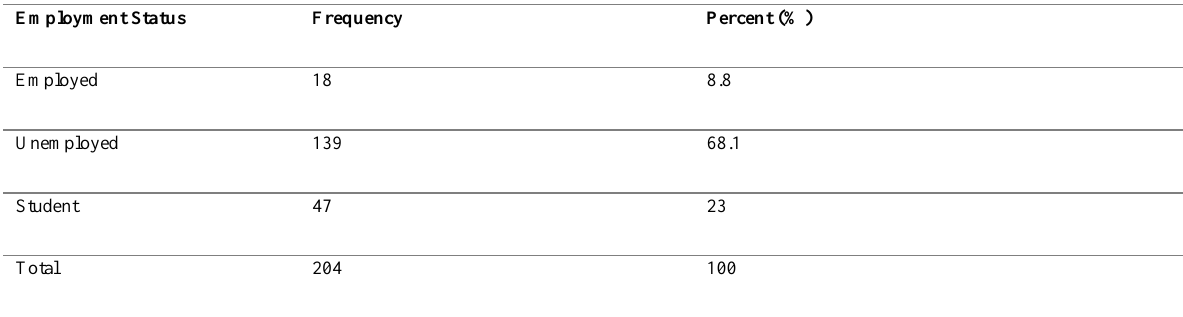
Table 4: Employment Status of Participants before Migrating to Urban Centres